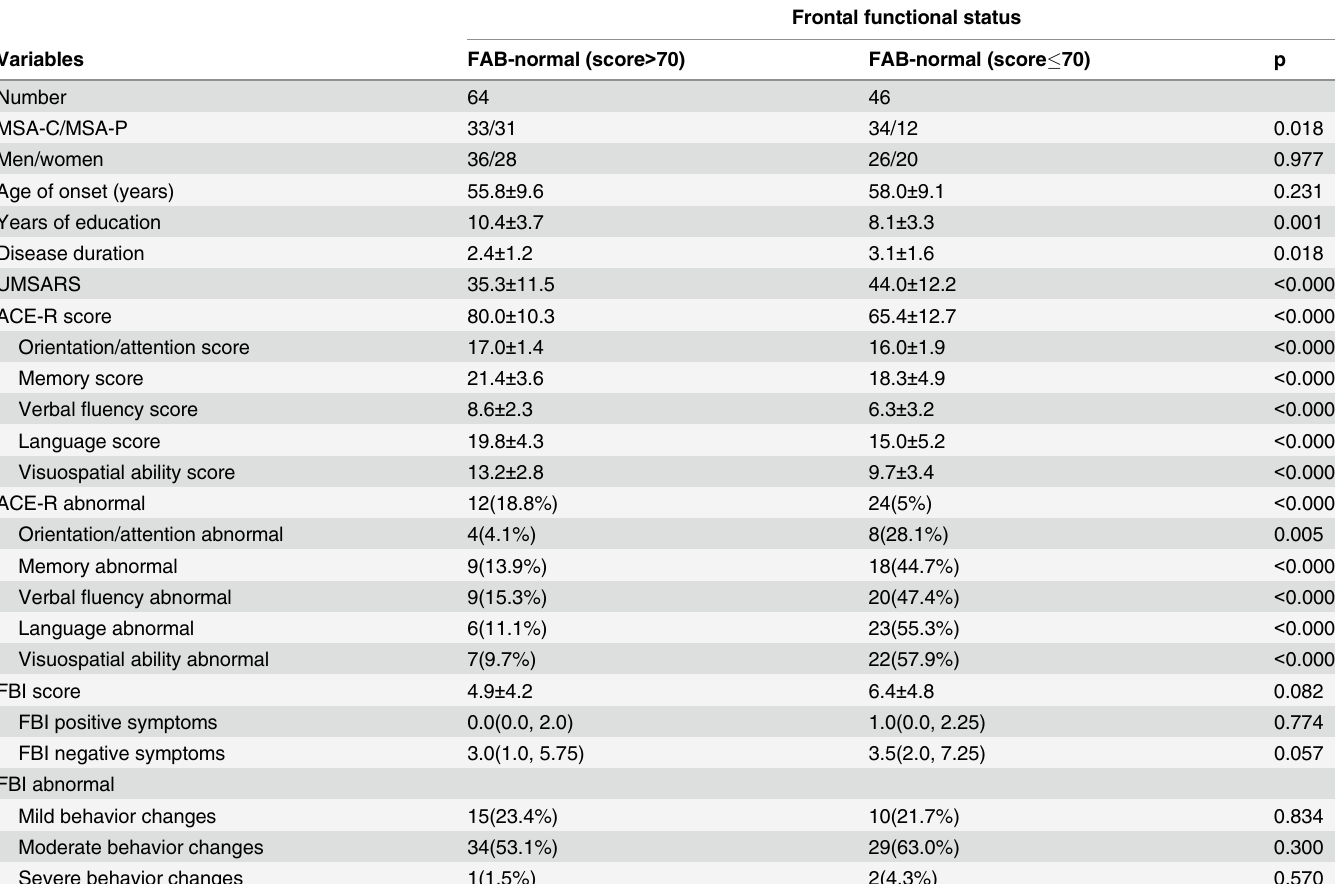
Table 3. Demographic and clinical characteristics of the MSA patients in terms of frontal functional